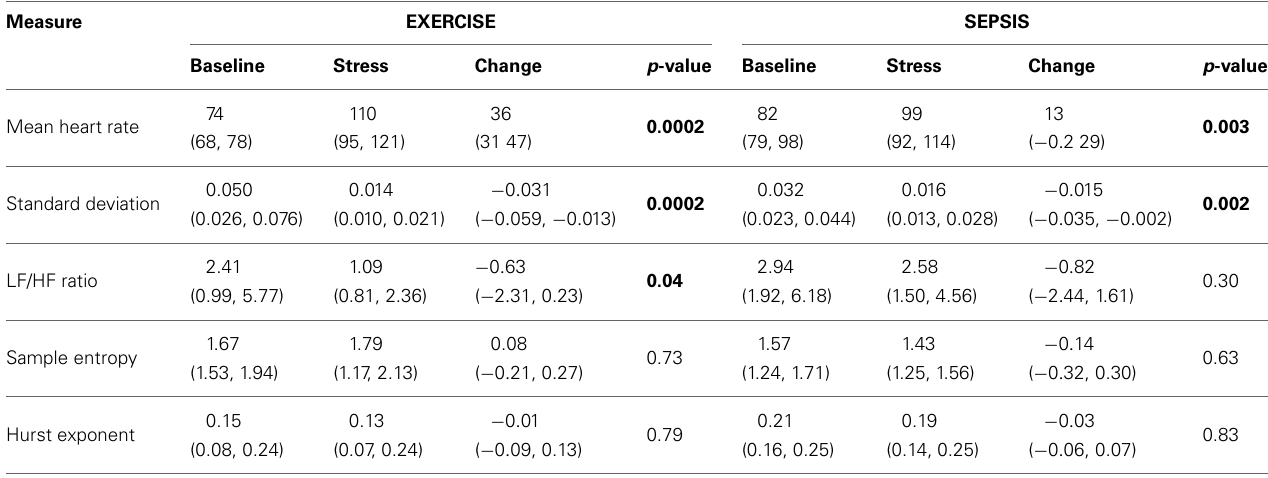
Table 3 | Statistical results.